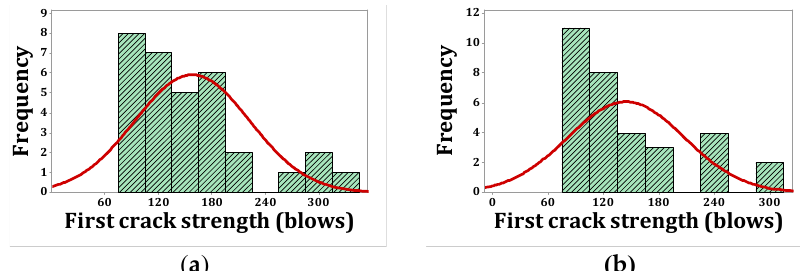
Figure 17. Normal probability plots for first crack (dry): ( a ) R, ( b ) F2, ( c ) F3.